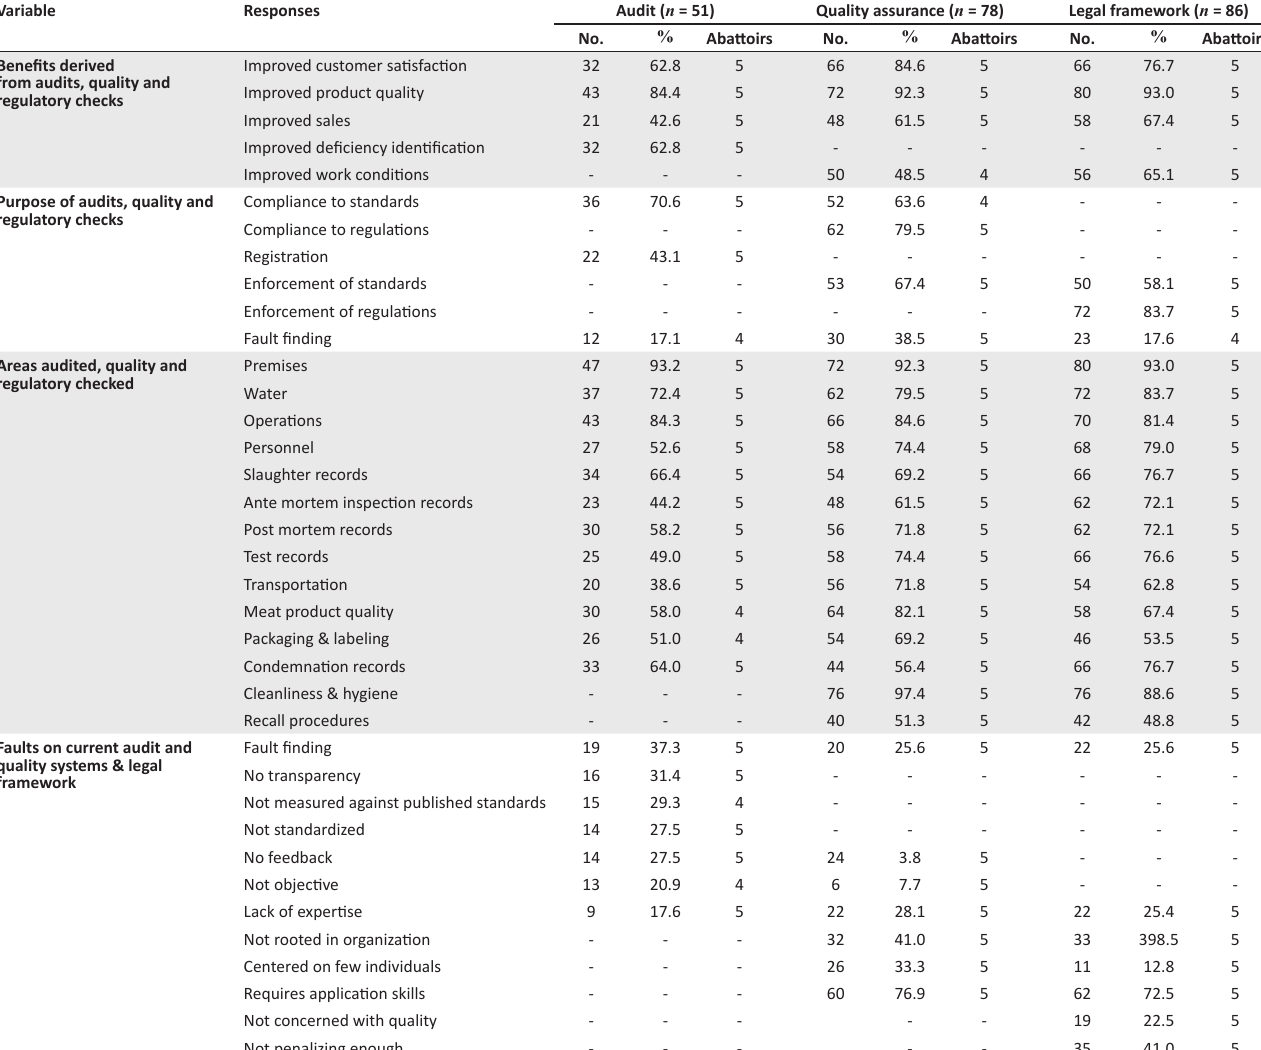
TABLE 4: Summary of responses to major issues on audit, quality and legal